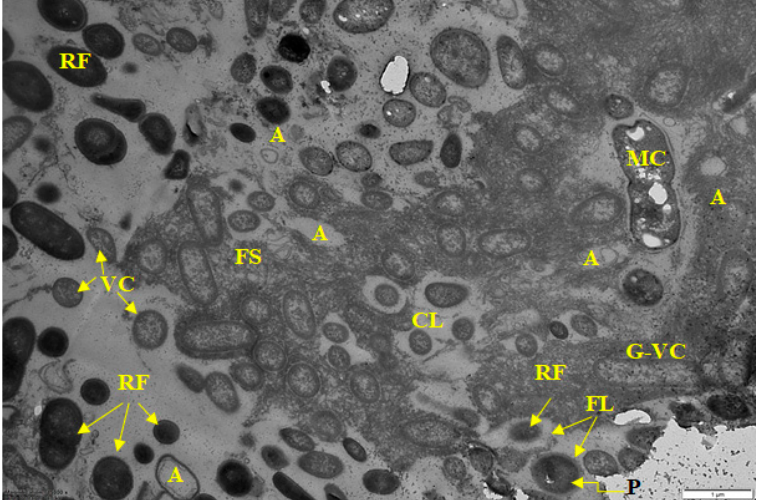
Figure 3. Electron micrograph of sample 2 biofilm. Designations: VC—vegetative cells; G-VC—vegetative cells of gram-negative bacteria; RF—resting forms; FS—fibrous structures of the matrix; CL—capsular layer; P—persisters; FL—fibrillar layer; A—autolyzed cell. Scale bar is 1 µm.